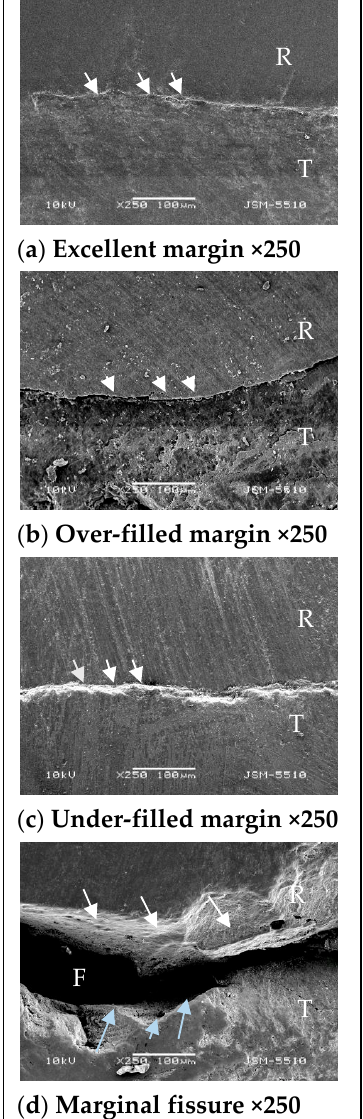
Figure 2. Criteria for assessing marginal adaptation, illustrated schematically by SEM images: R = restoration; T = tooth structure; F = fissure. ( a ) Excellent margin—arrows indicate the continuous restoration margin, covering precisely the preparation cavity margin; ( b ) over-filed margin—arrows indicate the continuous restoration margin hanging above the preparation cavity margin; ( c ) under-filled margin—arrows are pointing to the undercovered preparation cavity margin; ( d ) marginal fissure—white arrows are pointing to the restoration margin. Blue arrows are pointing to the cavity margin.